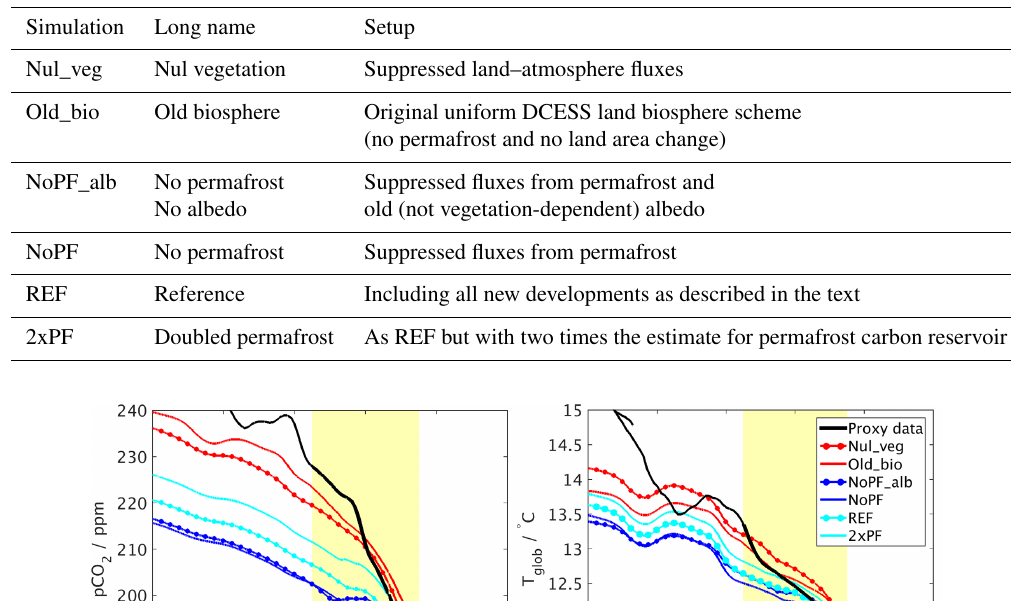
Table 3. Overview of the DCESS model simulations with short descriptions.